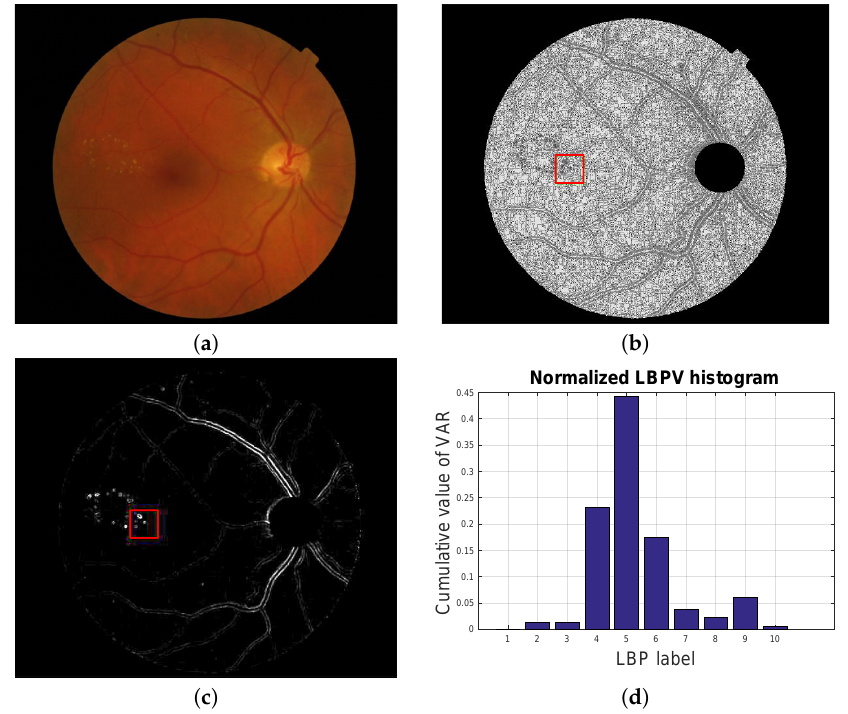
Figure 4. Local texture analysis. ( a ) Original fundus image, ( b ) LBP image and ( c ) VAR image with a patch highlighted in red and ( d ) the LBPV normalized histogram computed for the red